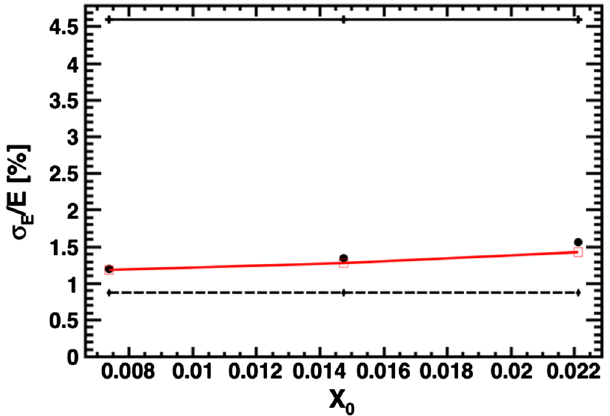
FIG. 6. Relative bandwidth of the photon beam estimated with CAIN (black dots), with the model proposed in this article (open red squares, red line), the model of Ref. [11] (black crosses, black line) and the same without the nonlinear term (black diamonds, dashed line) as function of X 0 . Lines are drawn as a further guide to the eye for the analytical models. The electron beam energy is varied from 300 to 900 MeV to realize this study. In order to be insensitive to the scaling of aperture θ with energy, Ψ 0 is kept max ¼ 300 μ rad, 150 μ rad, and 100 μ rad constant by choosing θ max for 300 MeV, 600 MeV, and 900 MeV, respectively.